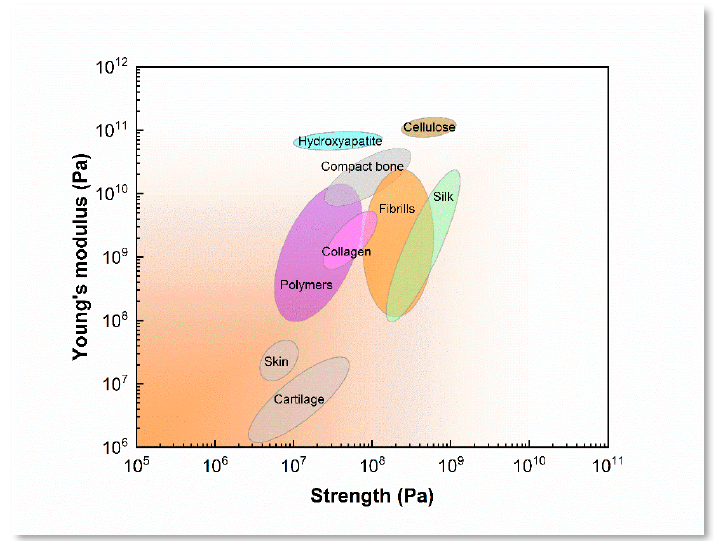
Figure 3. Comparation of the specific values of strength and stiffness of SF materials with natural and synthetic materials. Reproduced with permission from [65]. Copyright 2011, Nature.